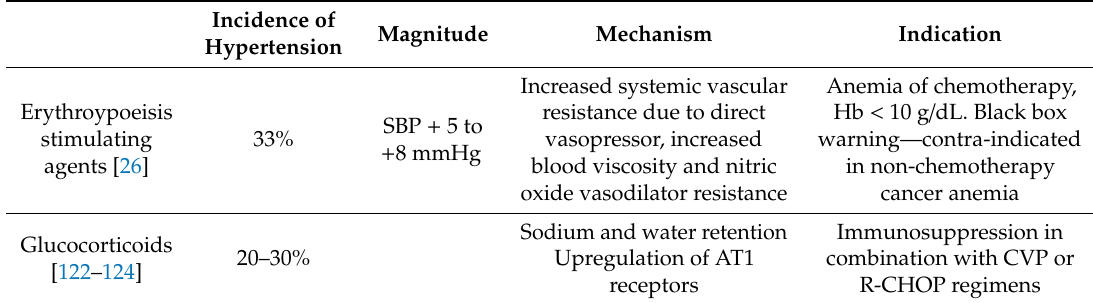
Table 4. Adjunct therapies and hypertensive cardiotoxicity data from